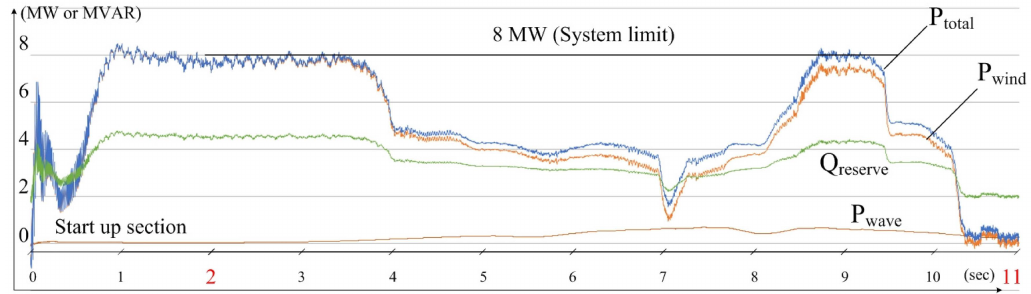
Figure 9. Output power and available reactive power curve of the HGS with previous control method (Case